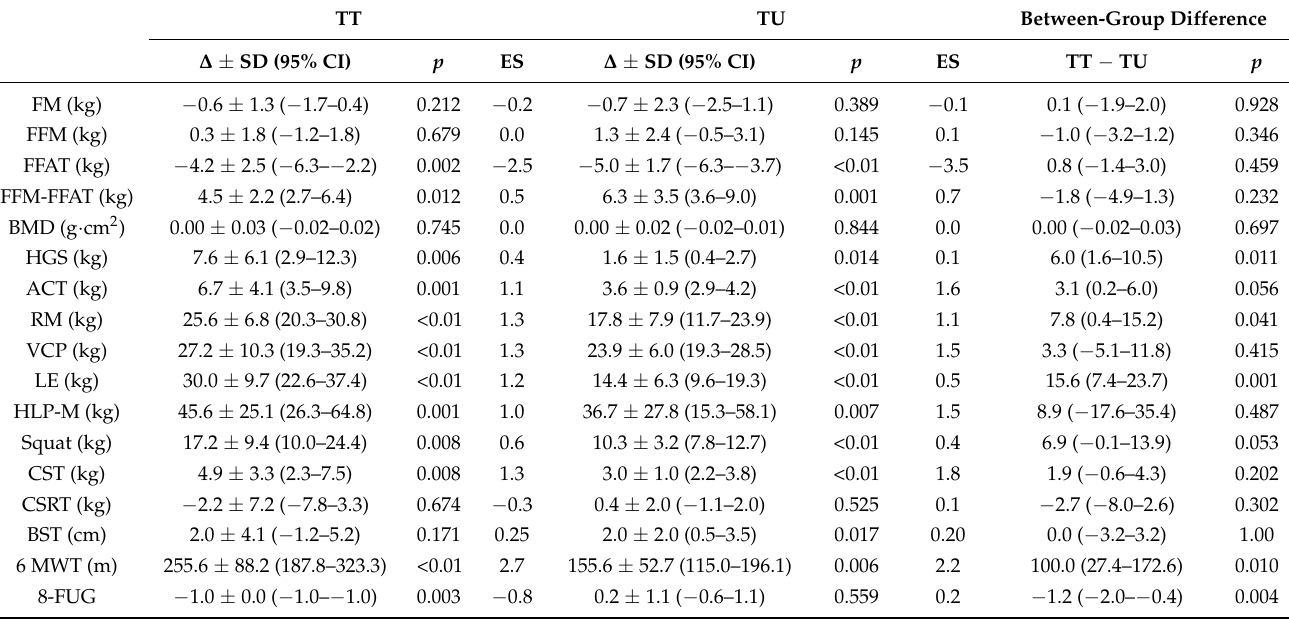
Table 2. Pre- and post-intervention data on the main study